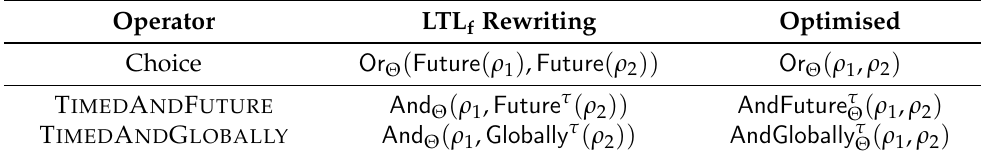
Table 8. Proposed operator semantics vs.